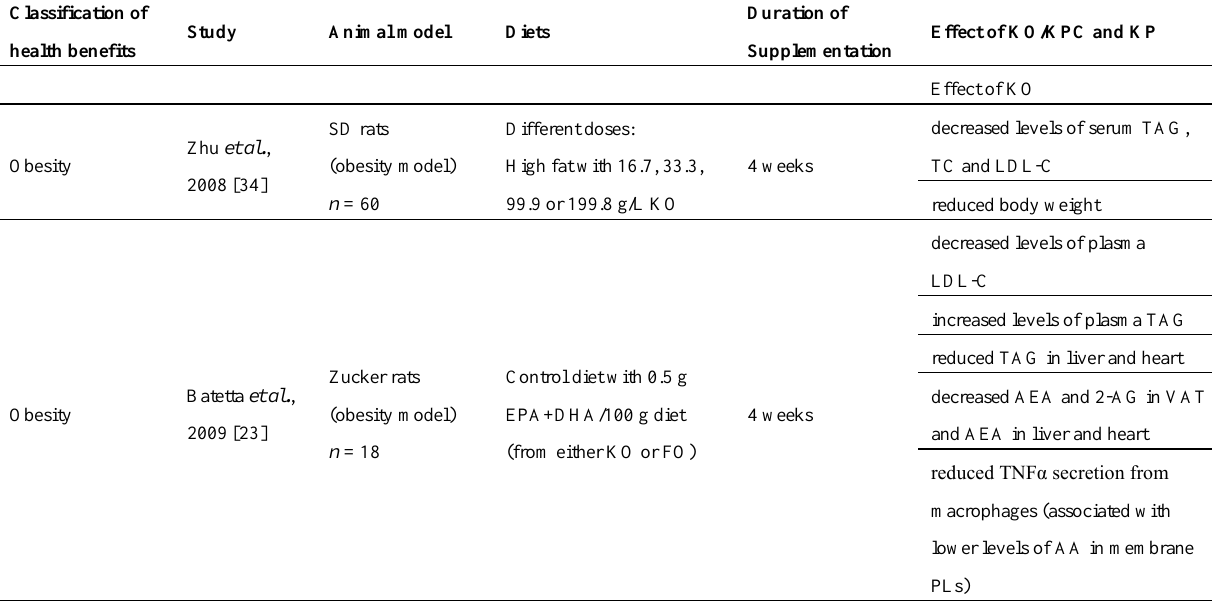
Table 2. Overview of the main animal studies with krill oil (KO), krill powder (KP) and krill protein concentrate (KPC) that are discussed in the selected health areas. Only one high dose study shows adverse events